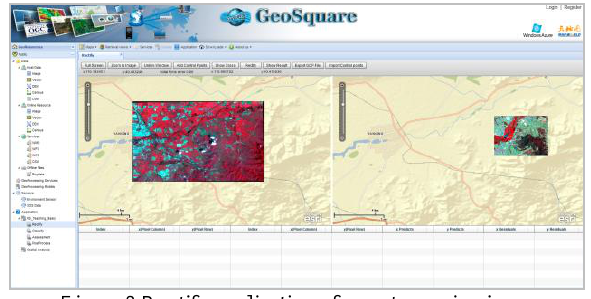
Figure 8 Rectify application of remote sensing image